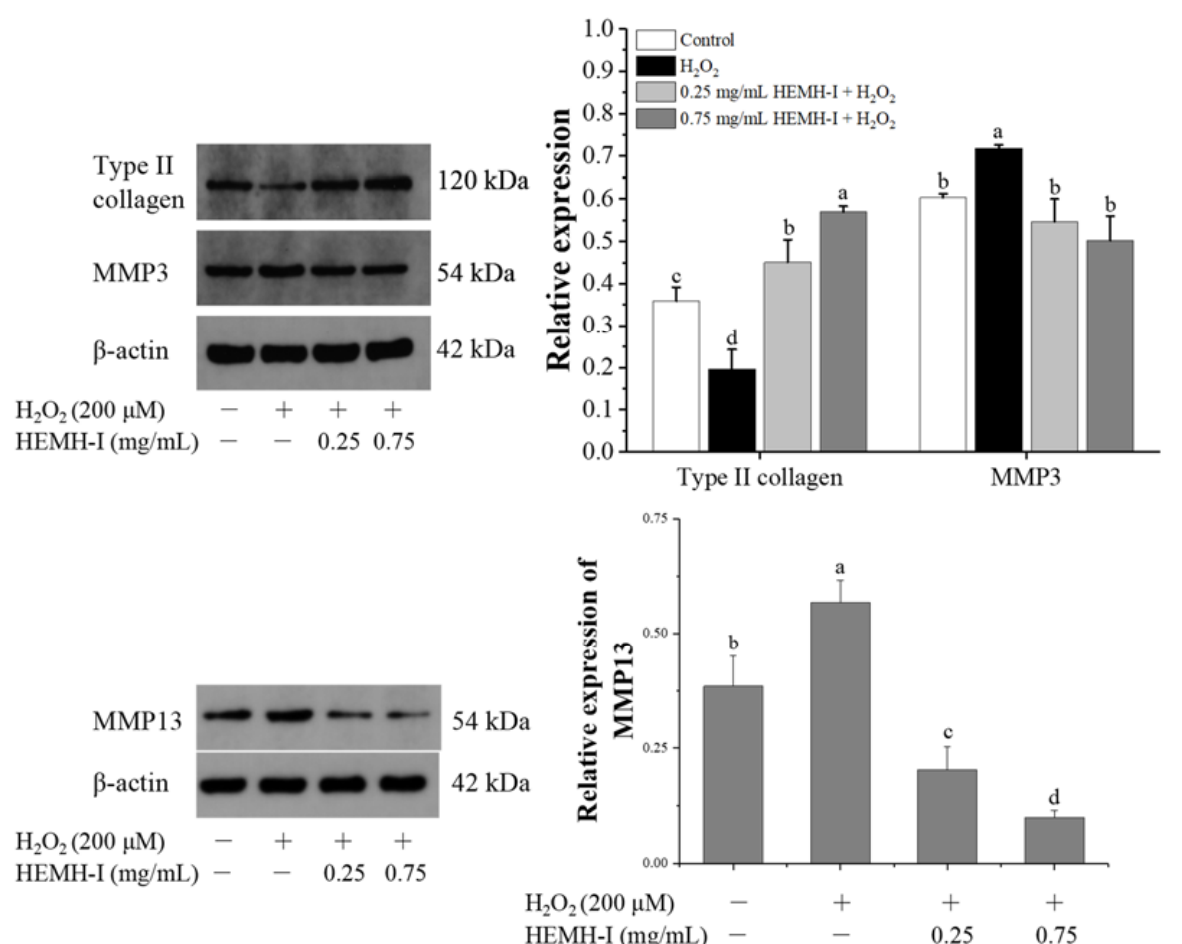
Figure 8. Effect of HEMH-I on the expression of Type II collagen, MMP3 and MMP13 in SW1353 chondrocytes. Values are expressed as mean ± SD ( n = 3). Means annotated with different letters (a–d) for the same parameter are significantly different ( p < 0.05).